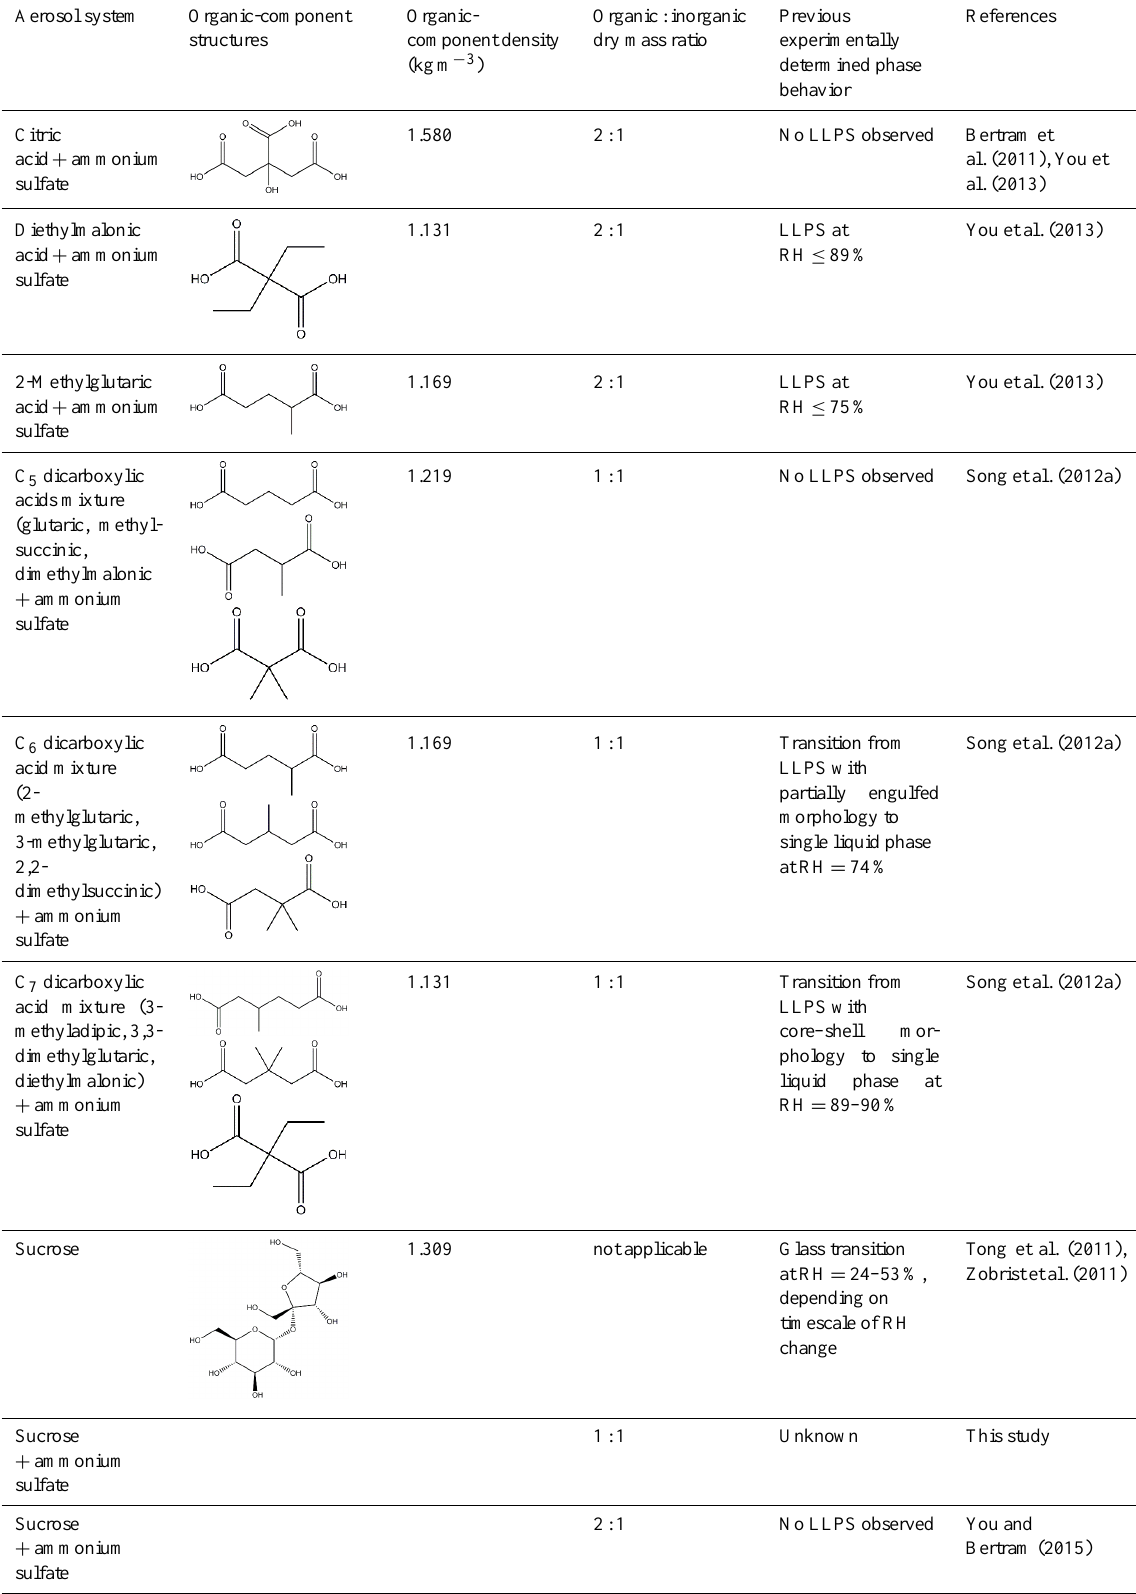
Table 1. Aerosol systems studied. Aerosol system Organic-component